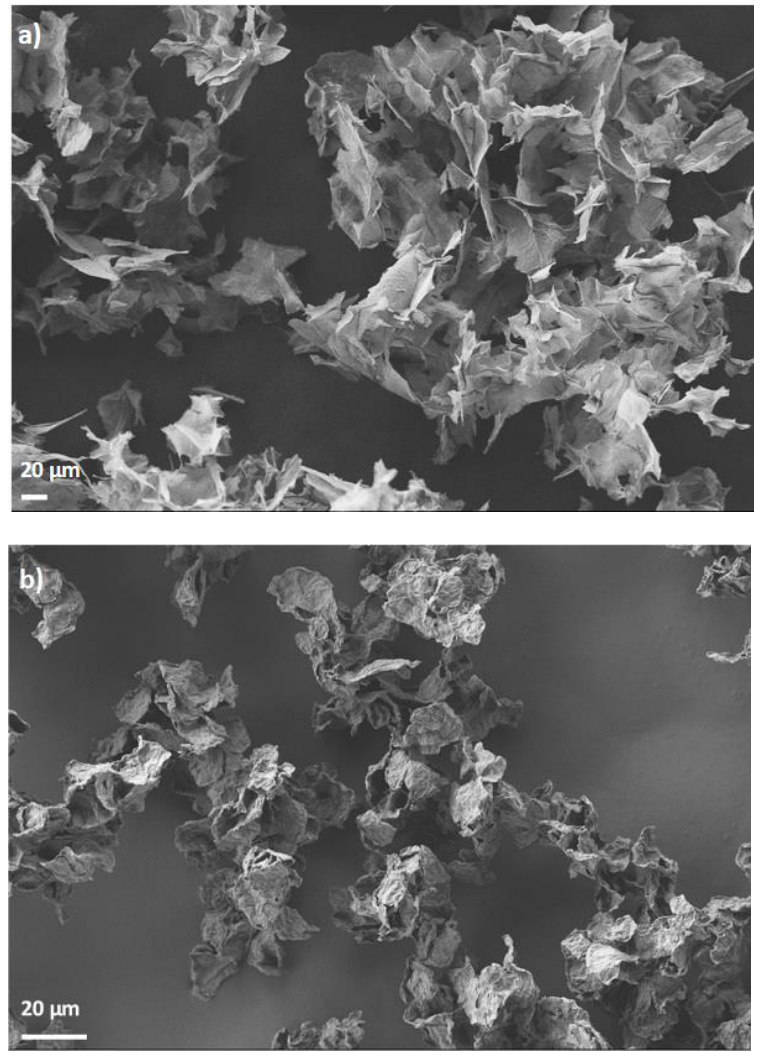
Figure 5. SEM images of ( a ) graphene oxide, ( b ) reduced graphene oxide.